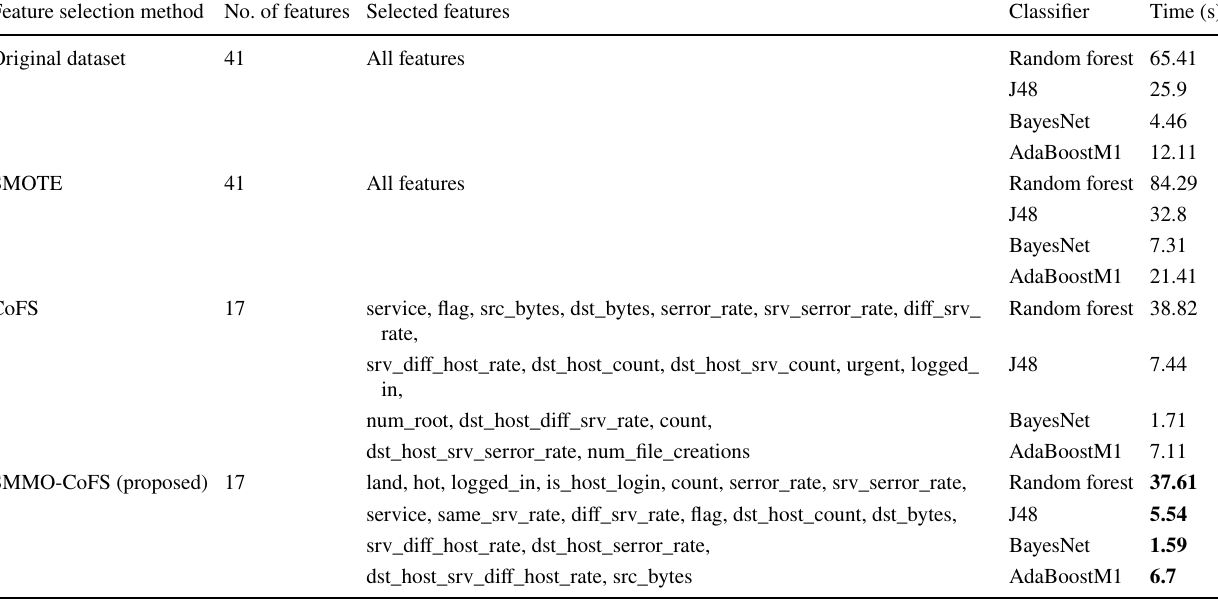
Table 7 Performance evaluation of SMMO-CoFS method in terms of time (s) using random forest, J48, BayesNet and AdaBoostM1 classifiers selection method No. of features Selected features